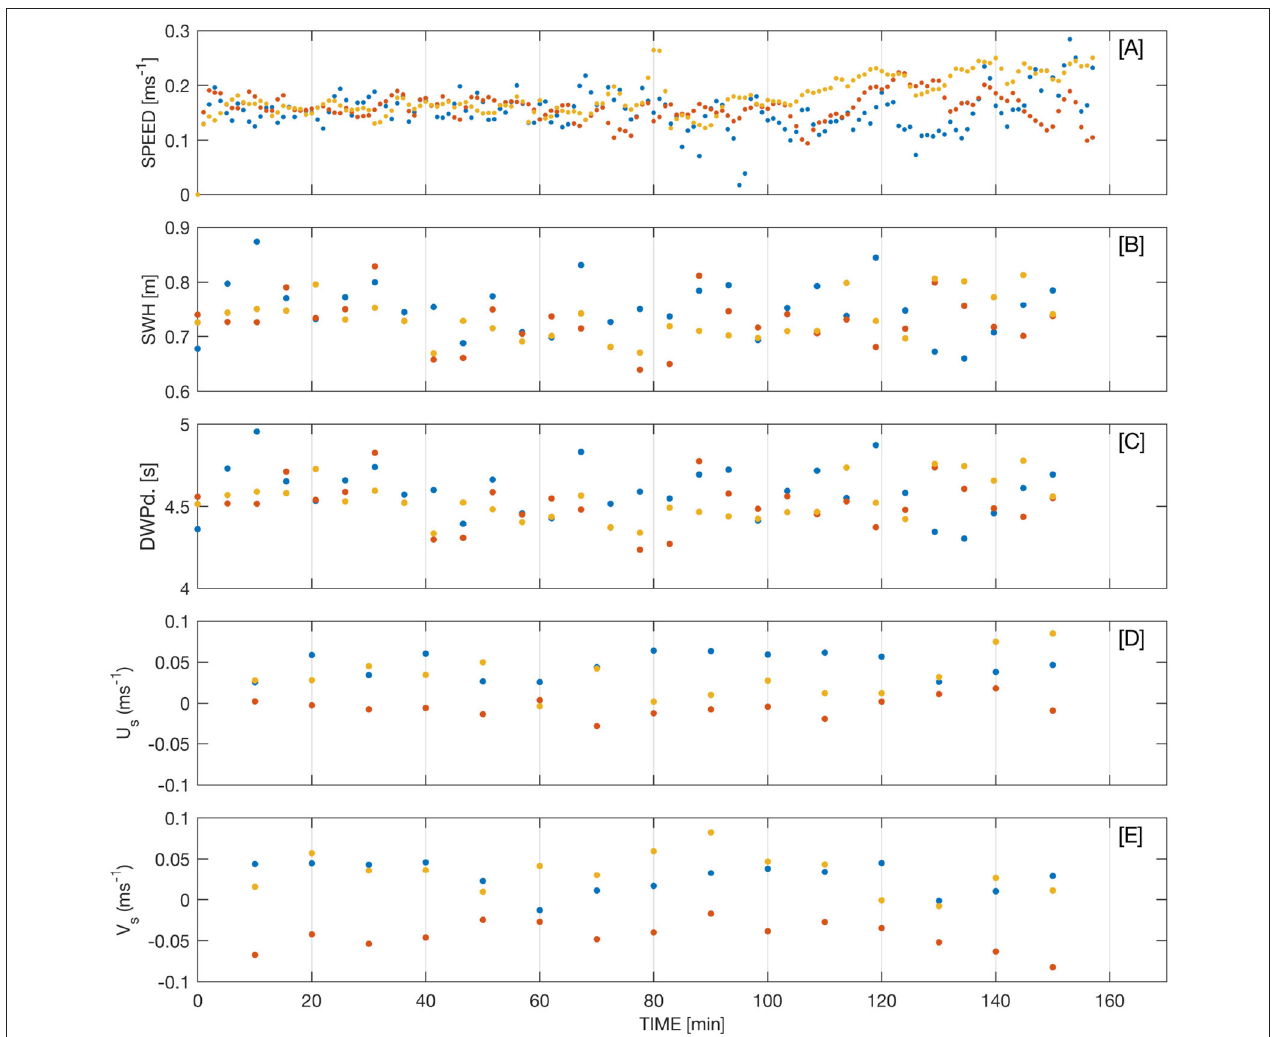
FIGURE 9 | (A) Drift speed of each wave buoy. (B) Significant wave height (SWH) and (C) dominant wave period (DWPd). The zonal and meridional components of the surface Stokes drift are plotted in (D,E) , respectively.